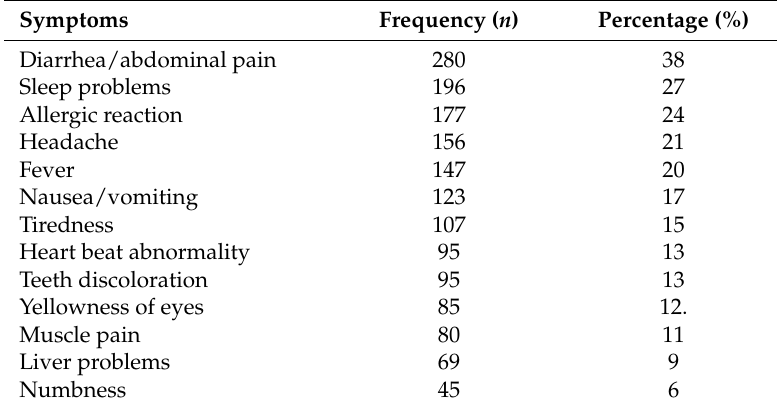
Table 3. Awareness of the side effects caused by antibiotics in the non-medical university students in Southern Punjab.